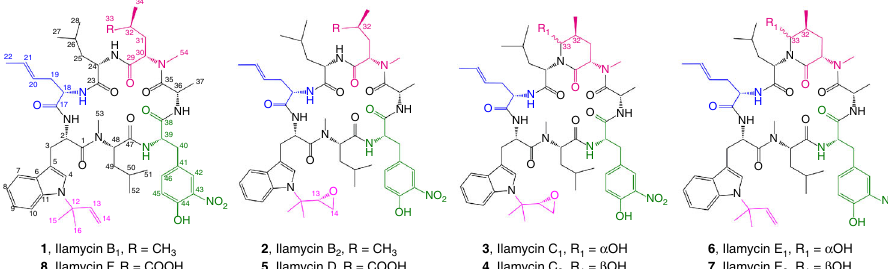
Fig. 1 Structures of ilamycins. Compounds 1 – 6 were isolated from S . atratus SCSIO ZH16 wild-type strain, compounds 6 – 8 were isolated from engineered mutant strains NATURE COMMUNICATIONS | 8: